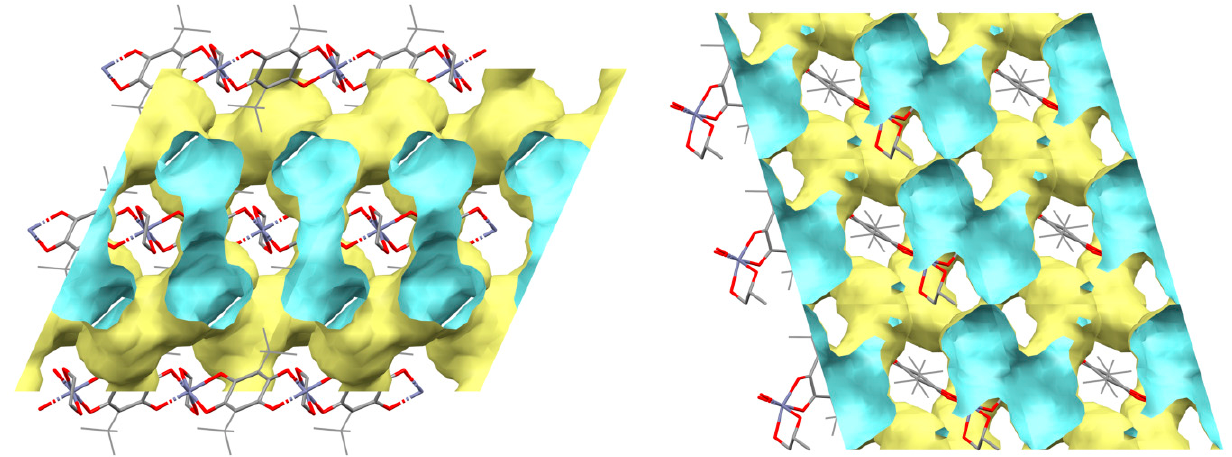
Figure 6. The view of pores in crystals of 1 ( left ) and 2 ( right ) along the (010) vector. The pore volumes were evaluated using probe radius 1.2 Å and approx. grid spacing 0.7 Å. Color code: the outer side of the pores is yellow; the inner side is blue.